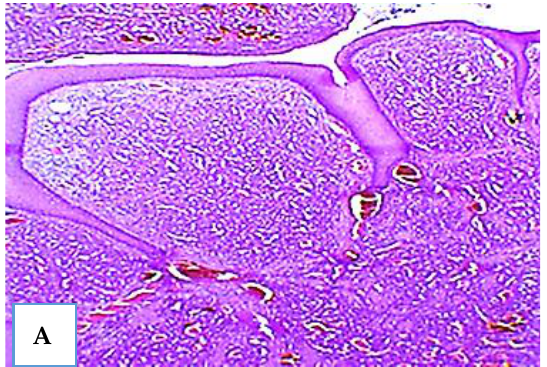
Figure (1): mean age of studied patients Independent t-test, ns =non-significant